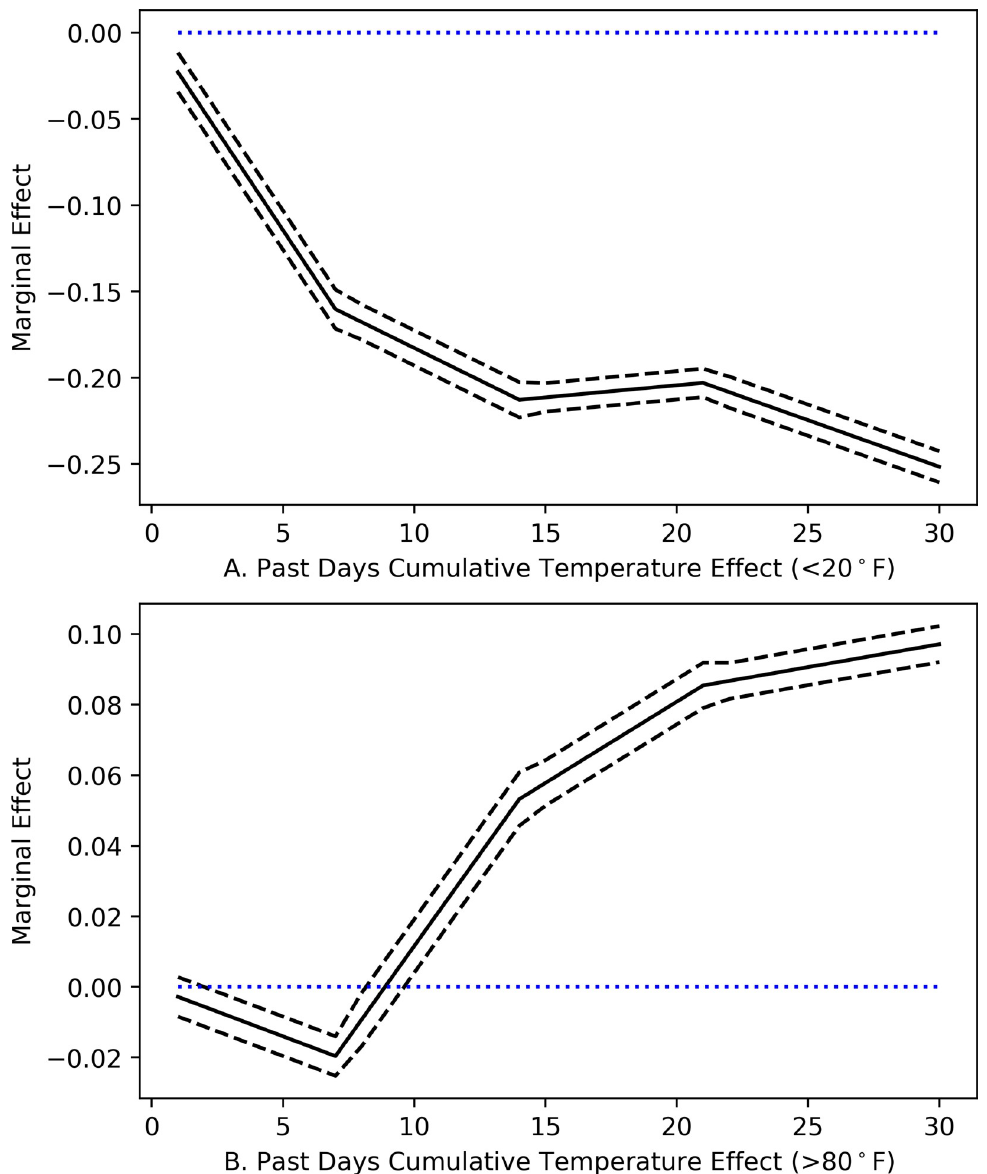
Fig 3. Effect of sustained very cold and hot days on the probability of self-reported mental health difficulties. Fig 3 is based on S2 Table. The slope is for the “cumulative effect” of the coldest (Fig 3A) and hottest (Fig 3B) bins for previous 1 to 4 weeks from the interview date that we have specified. The reference temperature bin for each week is 60–70˚F. The dashed lines represent 90% confidence intervals with the blue line indicating non-effect.